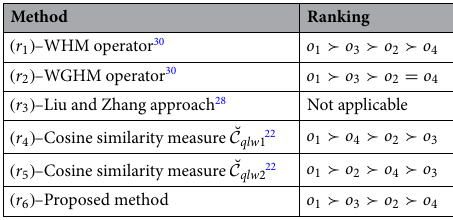
Table 13. Ranking results from different